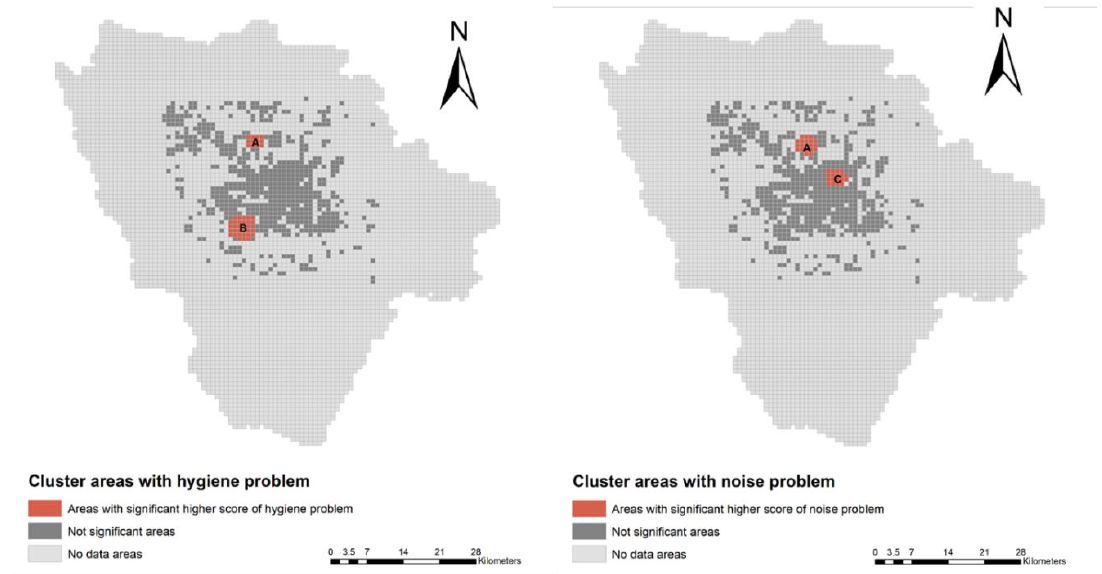
Figure 1. Spatial scan statistic results displaying cluster areas with hygiene and / or noise problems.